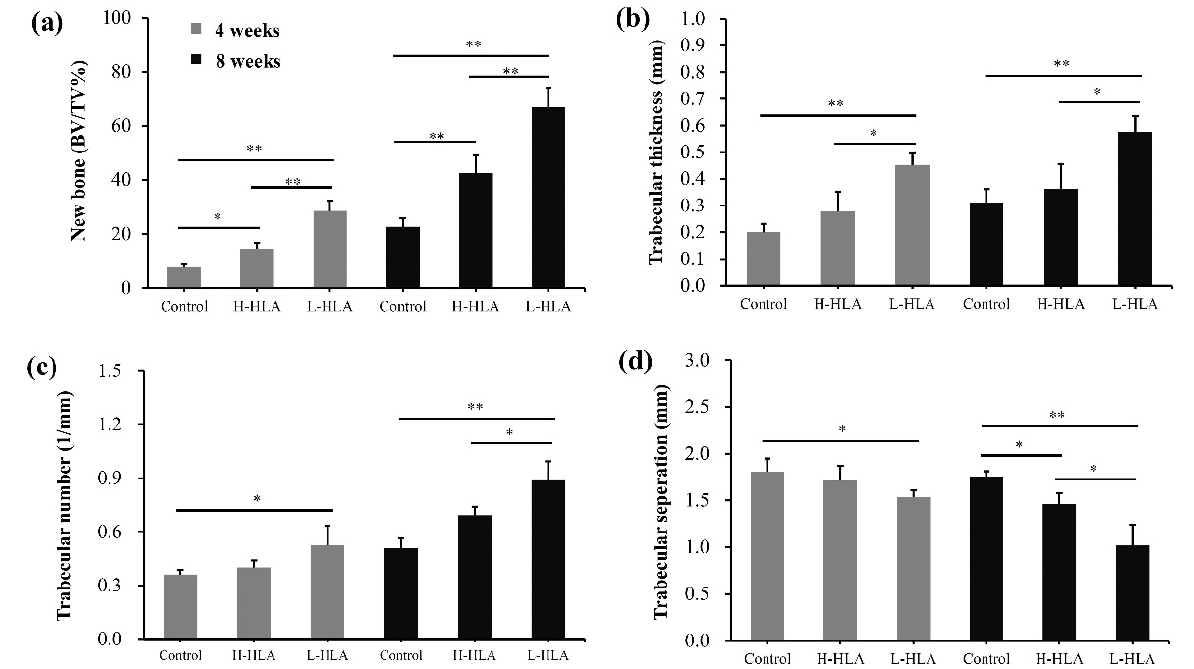
Figure 7. Micro-CT analysis of new bone formation ( a ), trabecular thickness ( b ), trabecular number ( c ), and amount of trabecular separation ( d ). Data are expressed as mean + standard deviation. Significance is indicated as * ( p < 0.05) and ** ( p < 0.01).